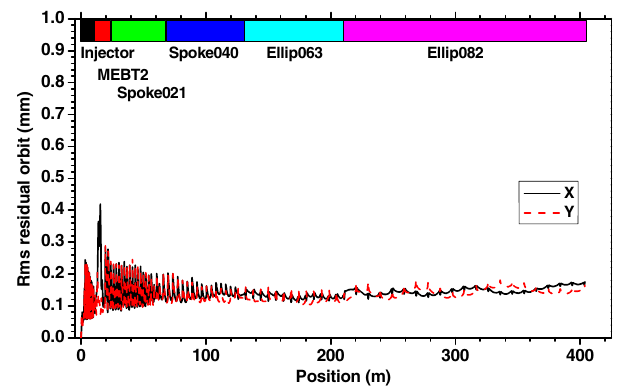
FIG. 33. Root-mean square residual orbit along the linac with errors and